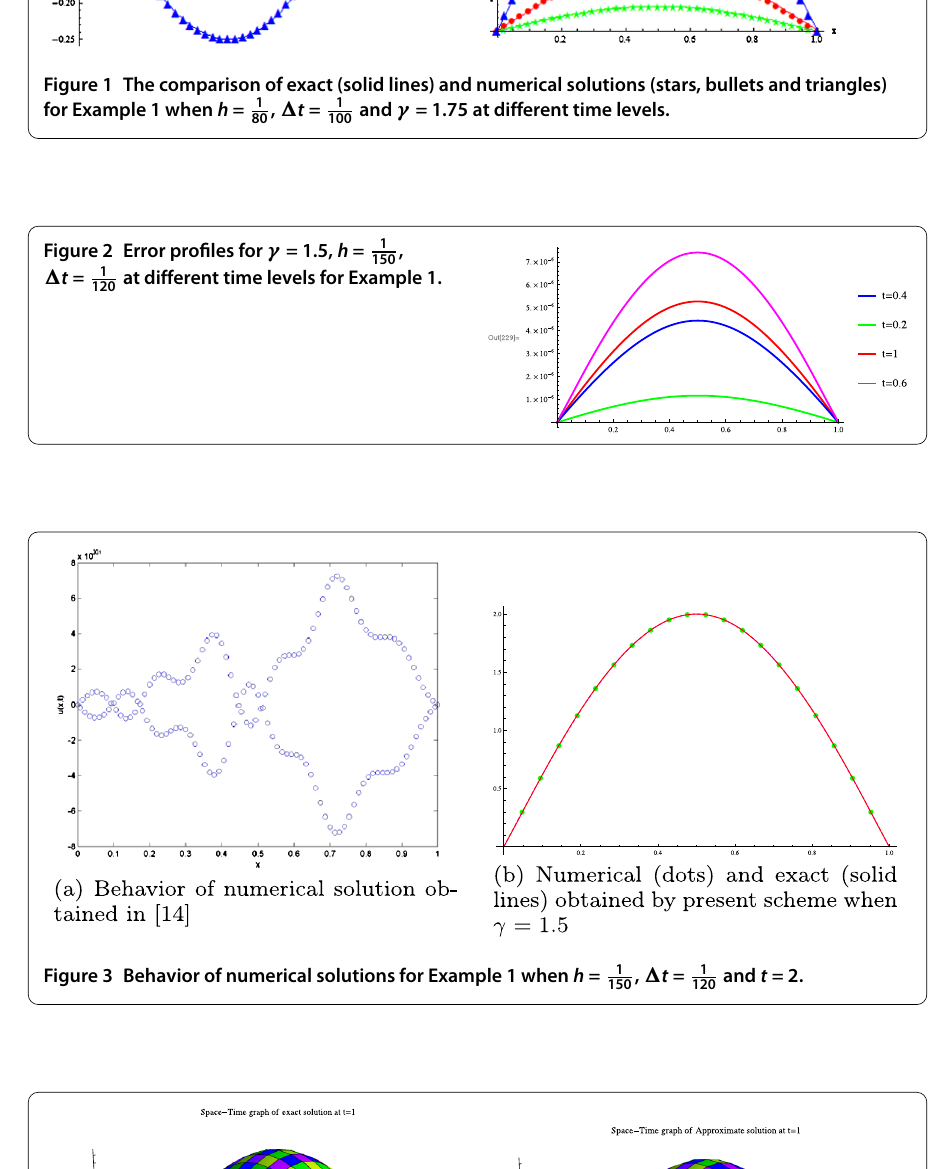
Figure 3 Behavior of numerical solutions for Example 1 when h = 1